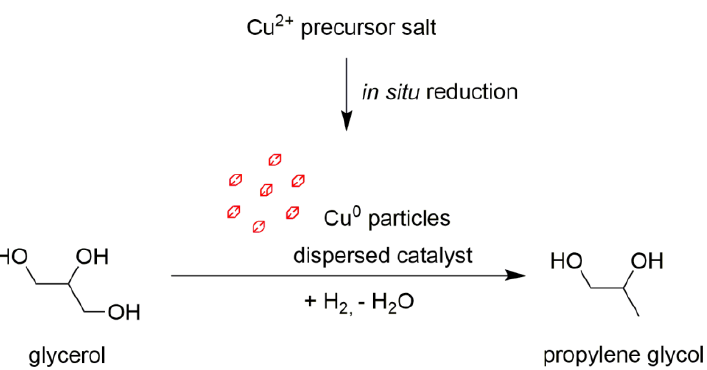
Figure 1. The concept of glycerol hydrogenolysis over in situ-generated ultrafine copper particles.